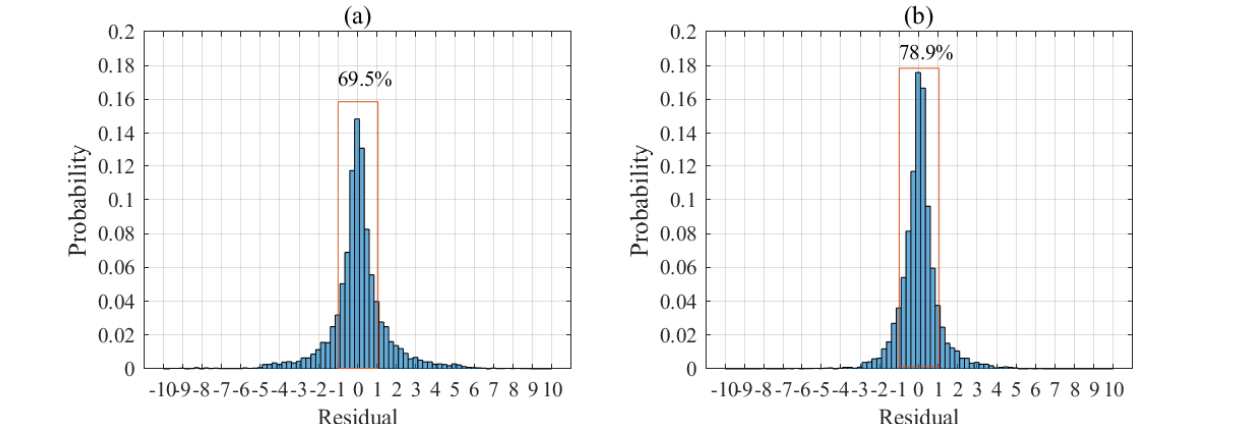
Figure 7. Residual distributions of the LSTM − AM model ( a ) and LSTM − AM − MLP model ( b ) on each hour of days (1 represents the first hour of days). The red bar inside the blue box denotes the median of the collection. The black bars above and below the box are maximum and minimum, the upper edge and bottom edge of the box are the third quartile and first quartile, respectively. The red crosses are outliers.